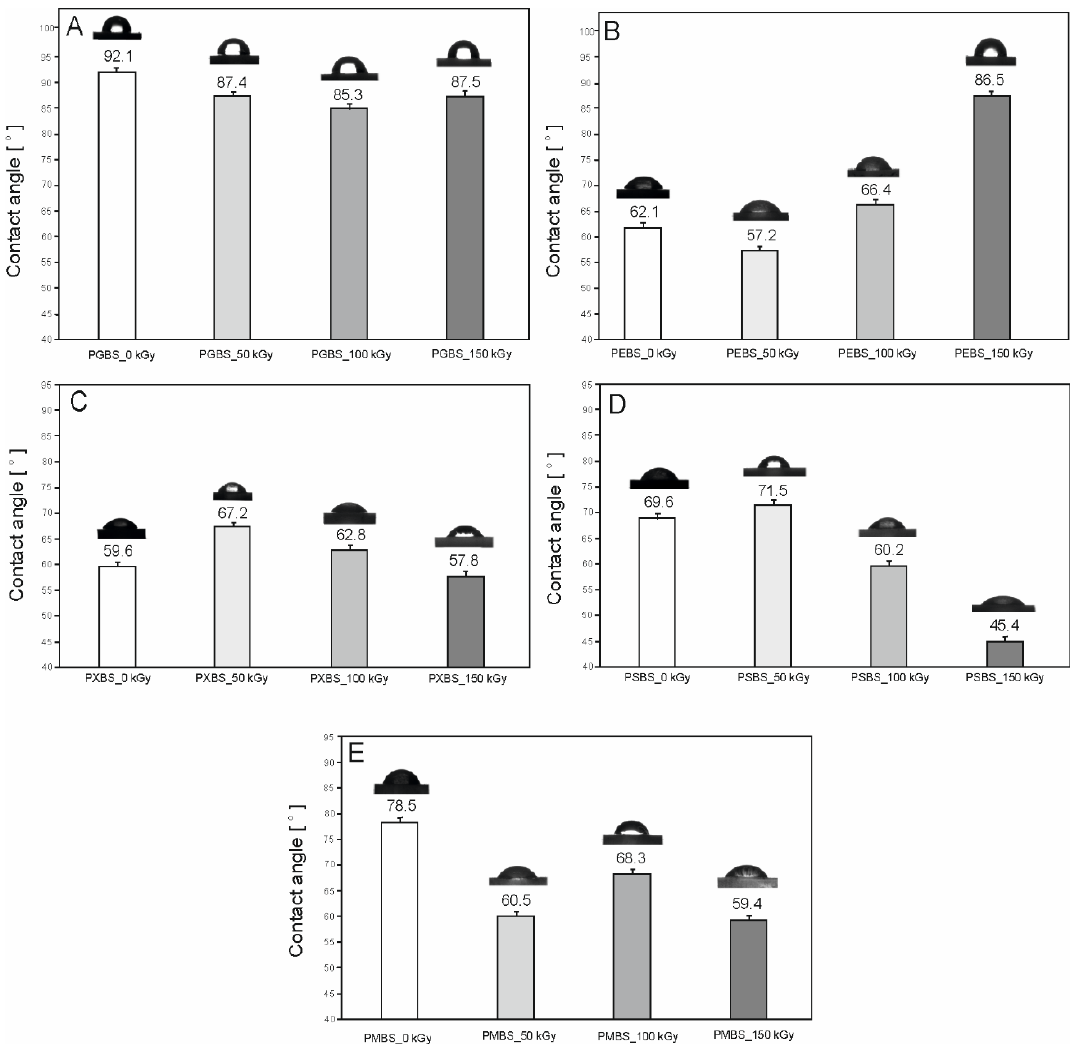
Figure 8. Contact angle of ( A ) PGBS, ( B ) PEBS, ( C ) PXBS, ( D ) PSBS, and ( E ) PMBS before and after irradiation.